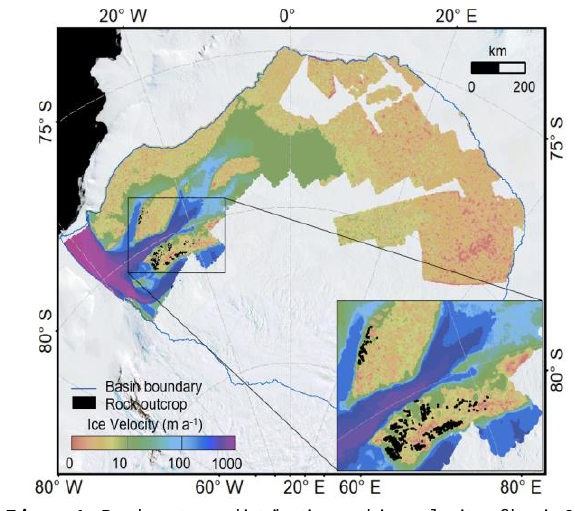
Figure 1. Rock outcrop distribution and ice velocity of basin 3, overlaid on the The Landsat image mosaic of Antarctica (Bindschadler et al.,